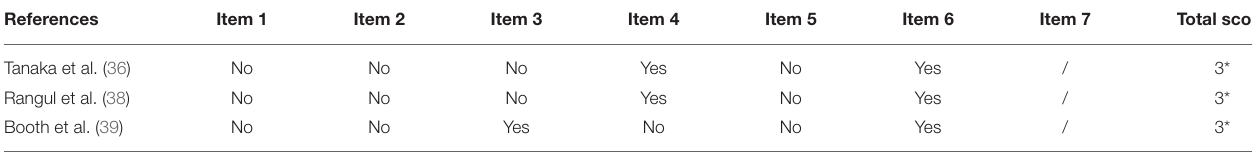
TABLE 4 | Methodological quality assessment for validity of the included